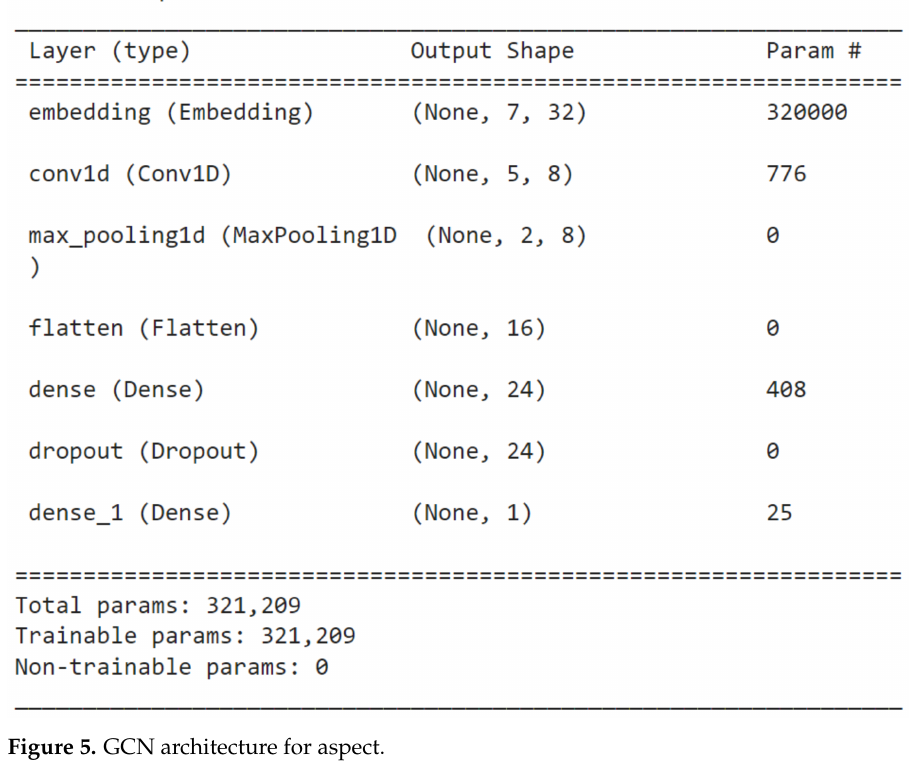
Figure 5. GCN architecture for aspect.